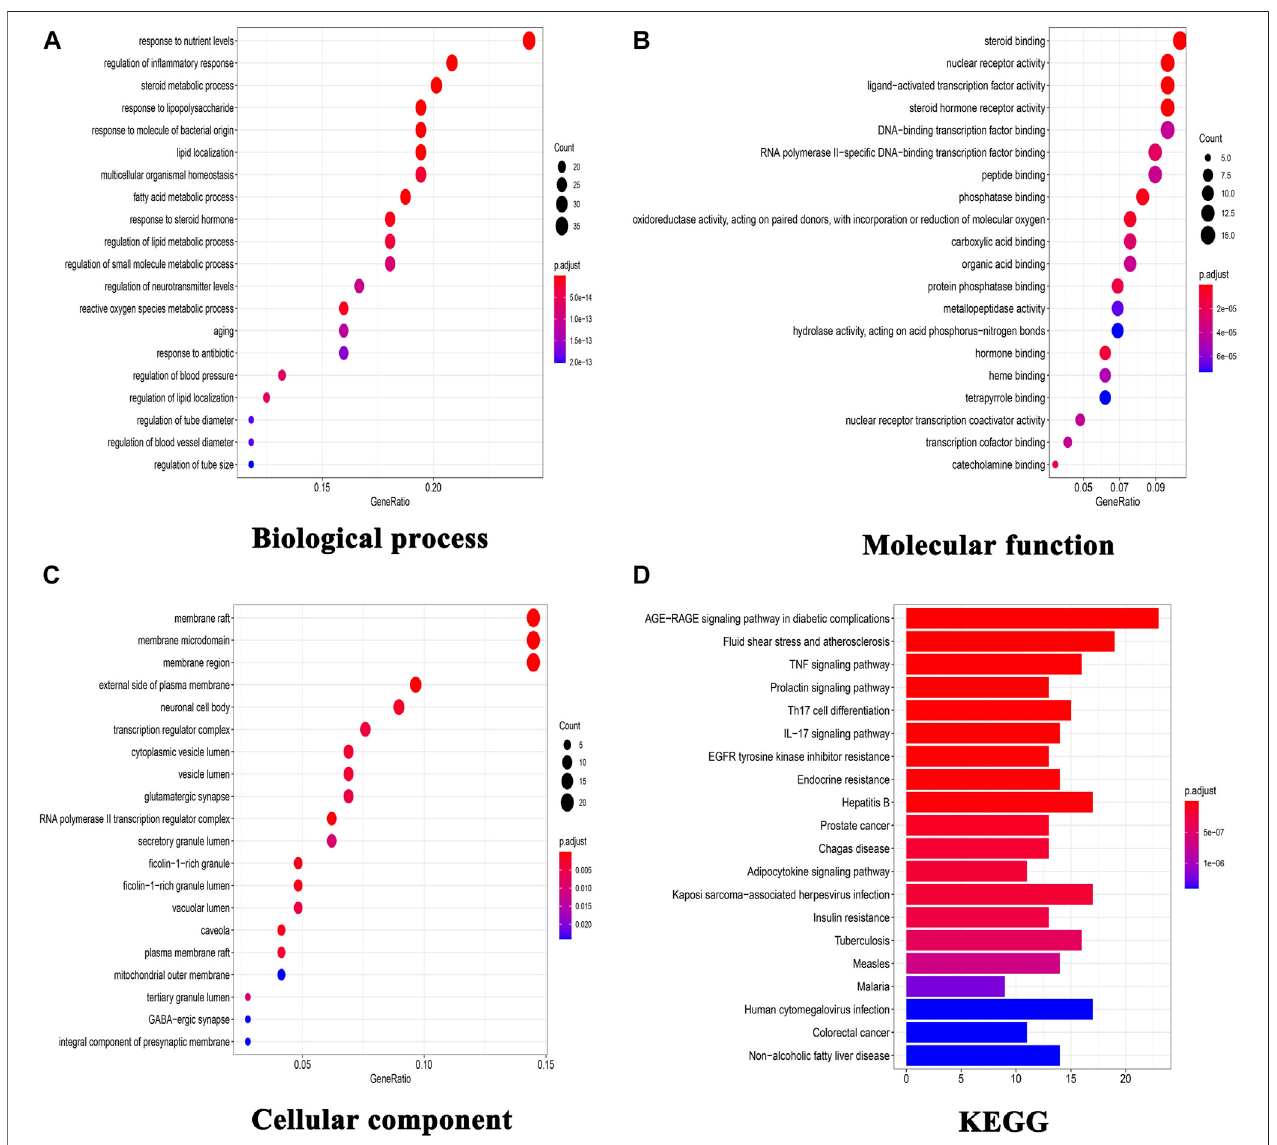
FIGURE 2 | GO functional enrichment analysis and KEGG pathway analysis. (A) GO enrichment analysis for biological process; (B) GO enrichment analysis for molecular function; (C) GO enrichment analysis for cellular component; (D) KEGG pathway analysis of these targets.